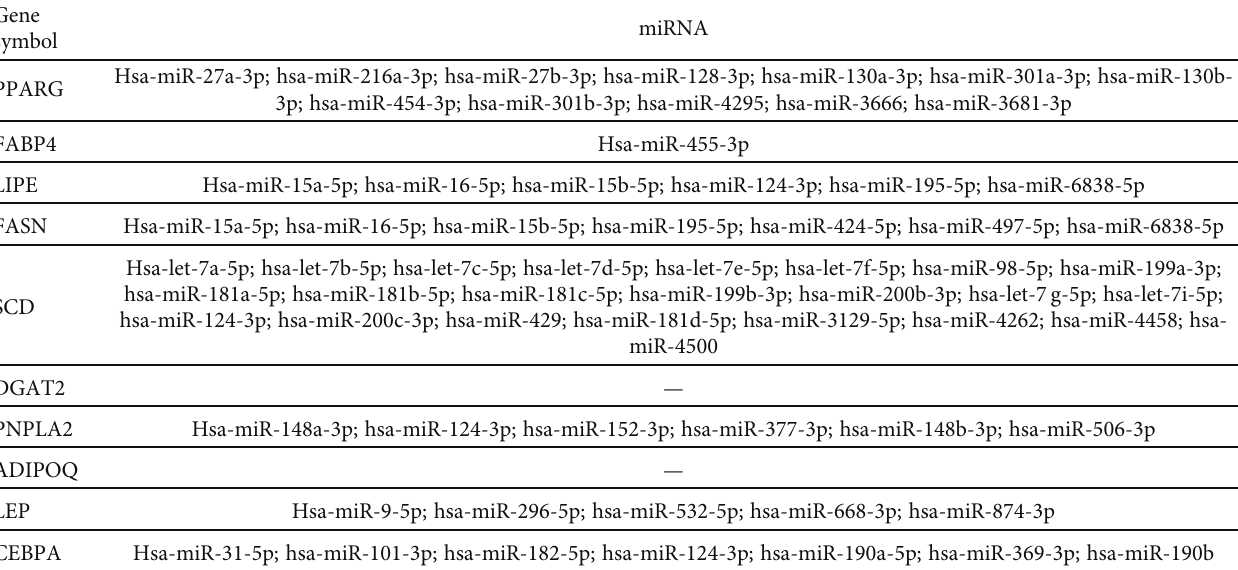
Table 2: Predicted